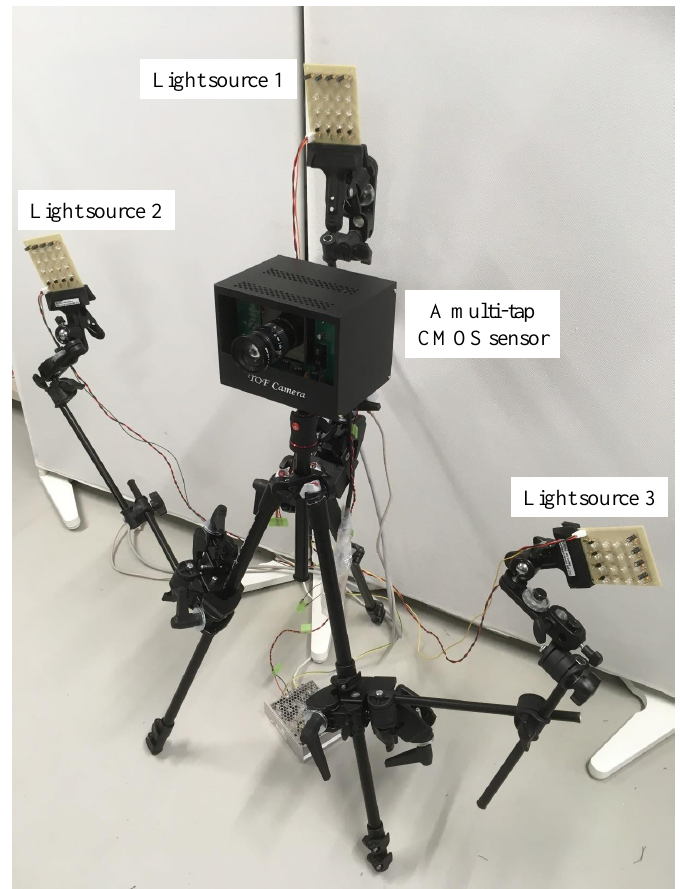
Figure 8. Prototype camera lighting system consisting of multi-tap CMOS image sensor and three light sources. Each light source is composed of 16 LEDs. We arranged the light sources such that the distance between each light source and the target object is equal to reduce the differences due to light attenuation effects. We used an Arduino Uno to synchronize the three light sources with the gate signals of the multi-tap CMOS image